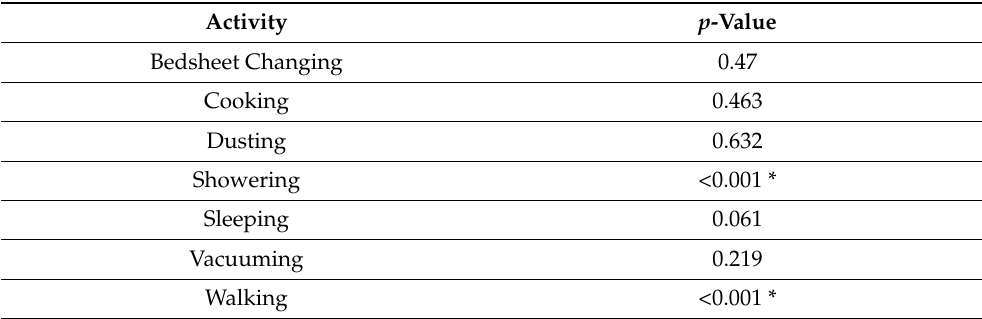
Table 4. Results of testing homogeneity of means of particle concentration ratios by each activity with all particle types